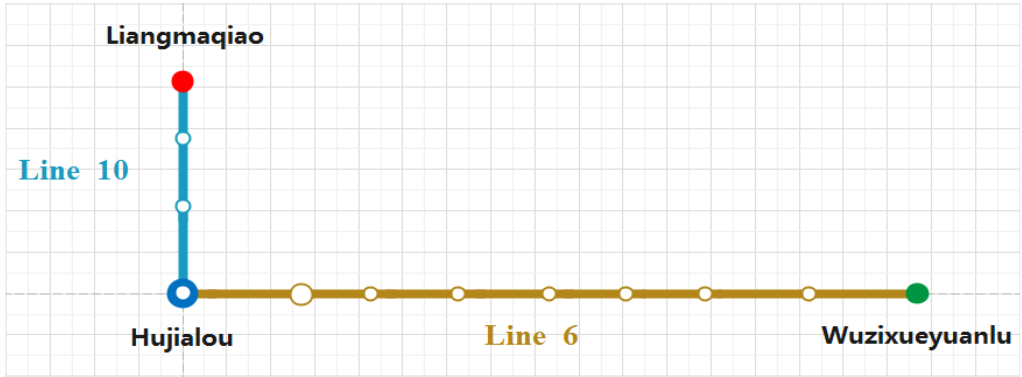
Figure 3. Transfer route from Wuzixueyuanlu Station to Liangmaqiao